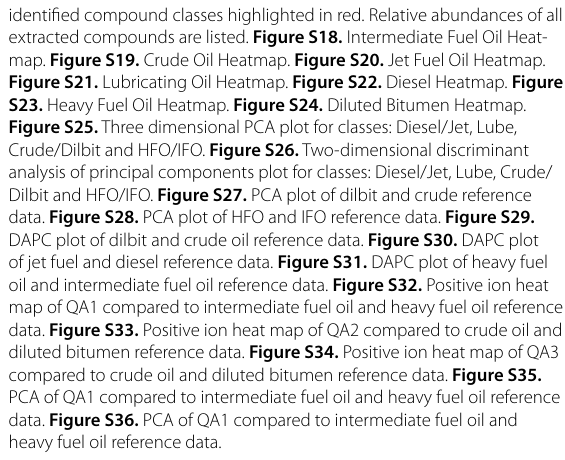
oil and intermediate fuel oil reference data. Figure S32. Positive ion heat map of QA1 compared to intermediate fuel oil and heavy fuel oil reference data. Figure S33. Positive ion heat map of QA2 compared to crude oil and diluted bitumen reference data. Figure S34. Positive ion heat map of QA3 compared to crude oil and diluted bitumen reference data. Figure S35. PCA of QA1 compared to intermediate fuel oil and heavy fuel oil reference data. Figure S36. PCA of QA1 compared to intermediate fuel oil and heavy fuel oil reference